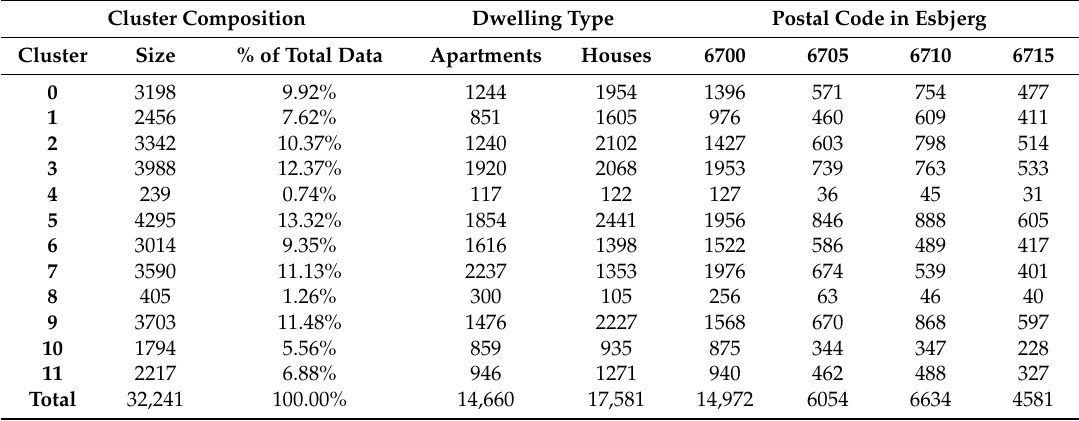
Table 3. Cluster composition table of the 12 different clusters. Only clusters 4 and 8 are markedly different from rest, with a very small cluster size. The remaining clusters sizes are well-balanced across all